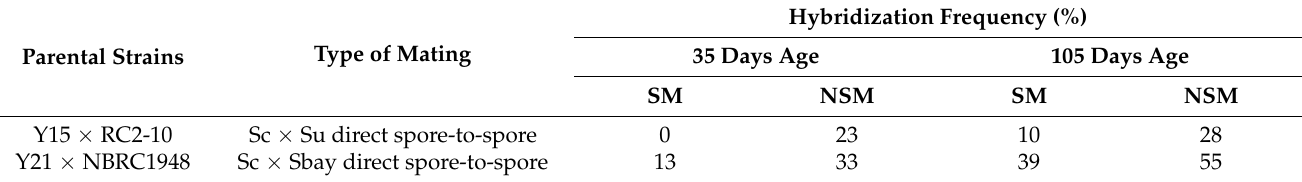
Table 5. Effect of spore residence in ACM on hybridization frequency. Abbreviations: SM, staggered mating; NSM, non-staggered mating; Sc, S. cerevisiae ; Su, S. uvarum ; Sbay, S. bayanus.